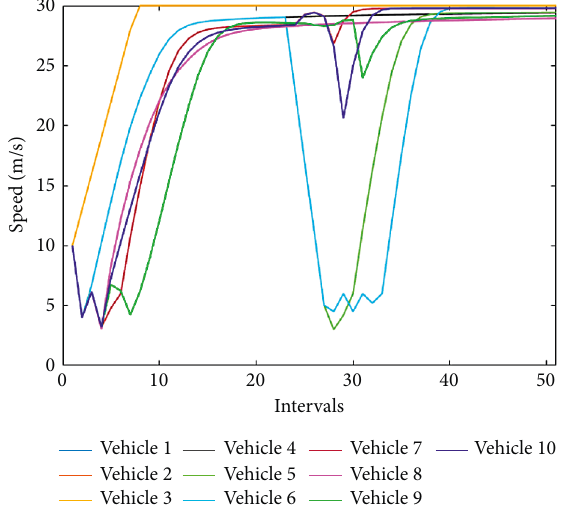
Figure 9: The vehicles’ speeds.